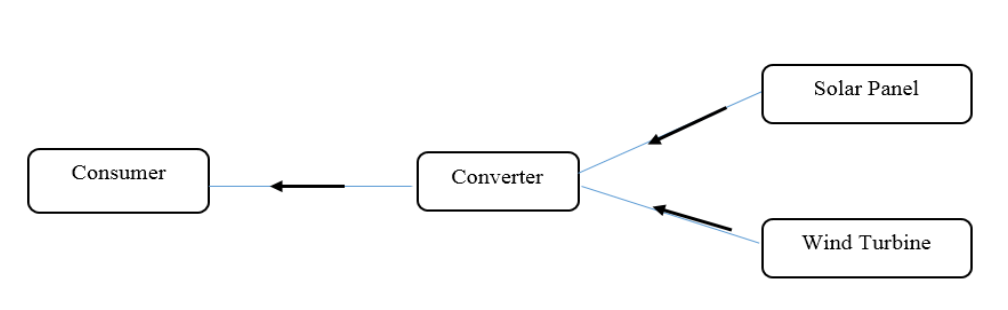
Figure 1. The General Form of the System Used in the